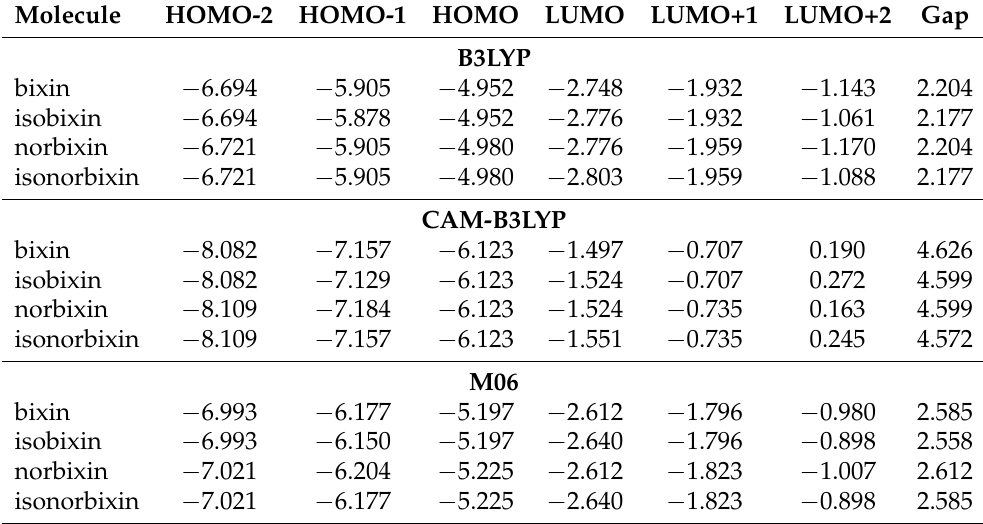
Table A11. Frontier MOs and gap energy values for the dyes in chloroform solution. These results were obtained by employing the 6-31G(d,p) basis set. All values are in electron-Volt (eV).